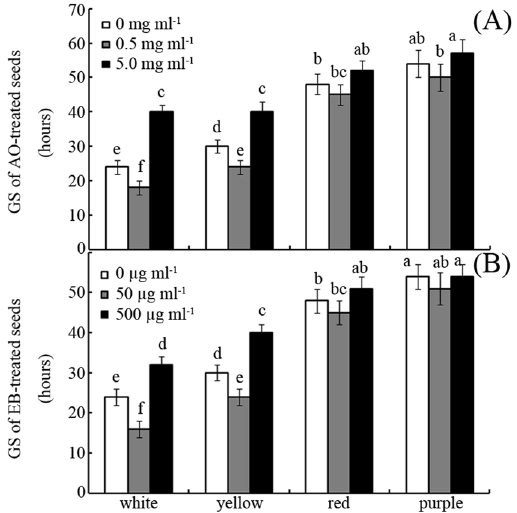
Figure 2. Effects of AO/EB on GS Effects of different concentrations of AO ( A ) and EB ( B ) on the GS of maize seeds. Bars represent standard deviations of means ( n = 5); means followed by the same letter are not significantly different ( p < 0.05) among treatments. EB, ethidium bromide; AO, acridine orange; GS, germination speed.